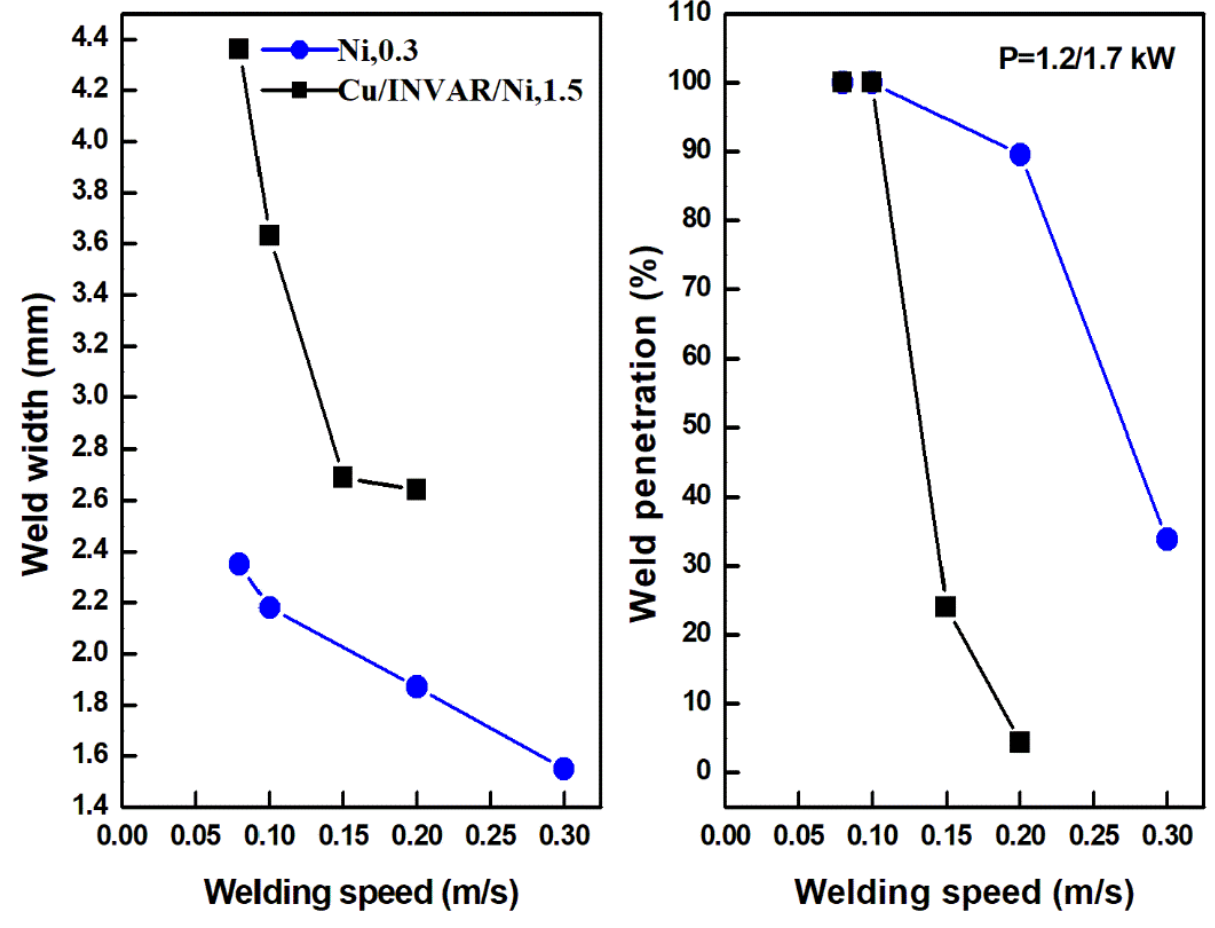
Figure 8. Effect of welding speed on the weld formation and weld